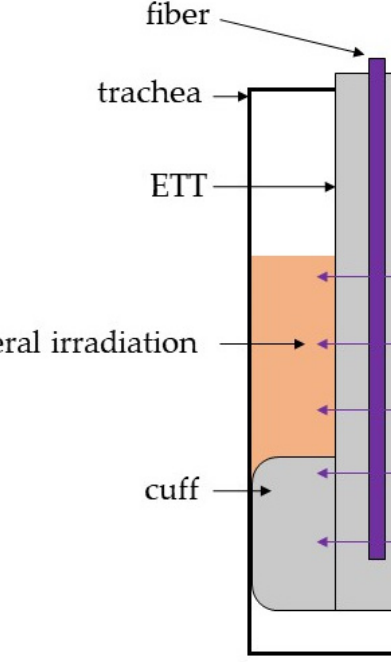
Figure 2. Scheme of sample drawing process in the trachea model.